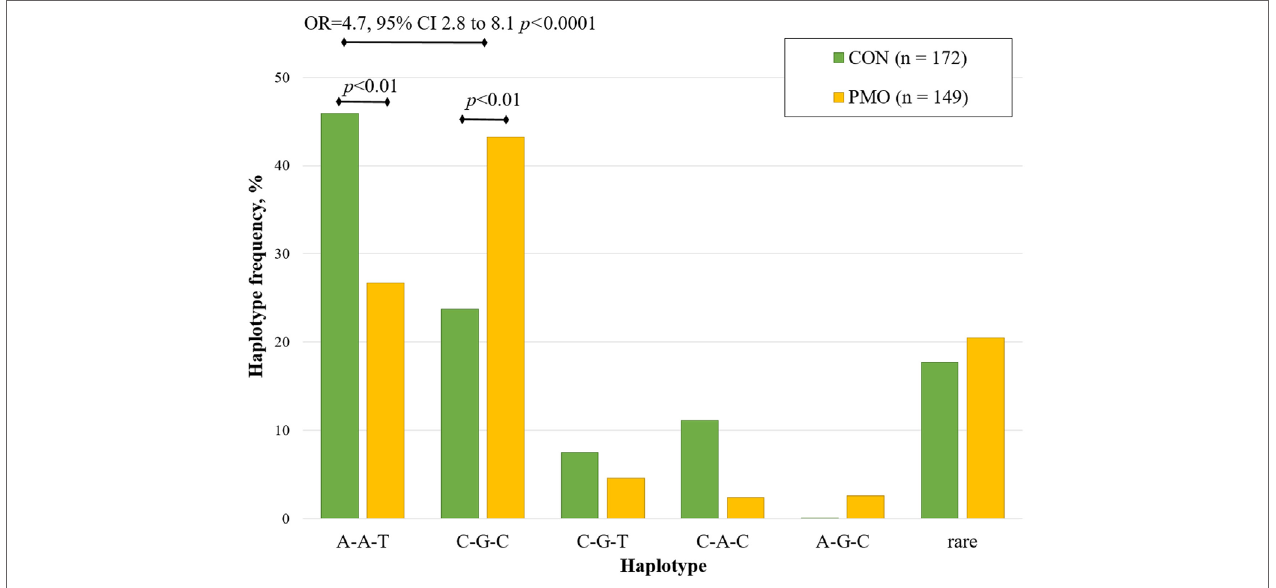
FiGURe 2 | Estimated haplotype frequency distribution of VDR ApaI, BsmI, and TaqI variants in the postmenopausal osteoporosis (PMO) and control (CON)